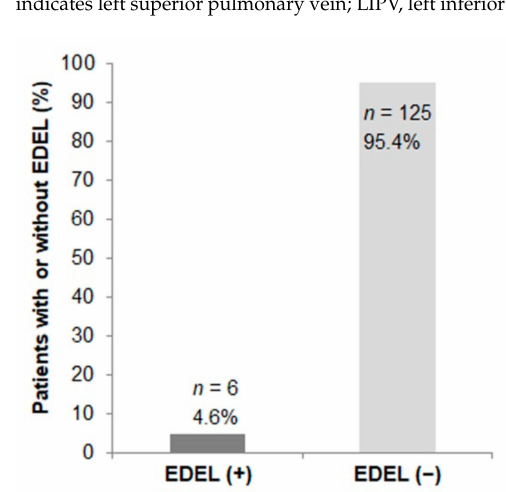
Figure 3. Incidence of endoscopically detected esophageal lesions (EDEL). Patients with EDEL were all symptom-free. According to the Kansas City classification (KCC) [5], one type 1 lesion (erosion) and five type 2a lesions (superficial ulceration) were detected. No deep ulceration, esophageal perforation or atrio-esophageal fistula was